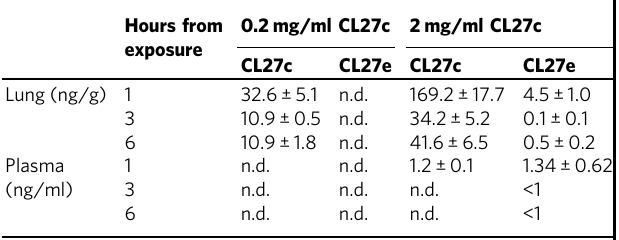
Values are the mean of at least three animals. n.d. not